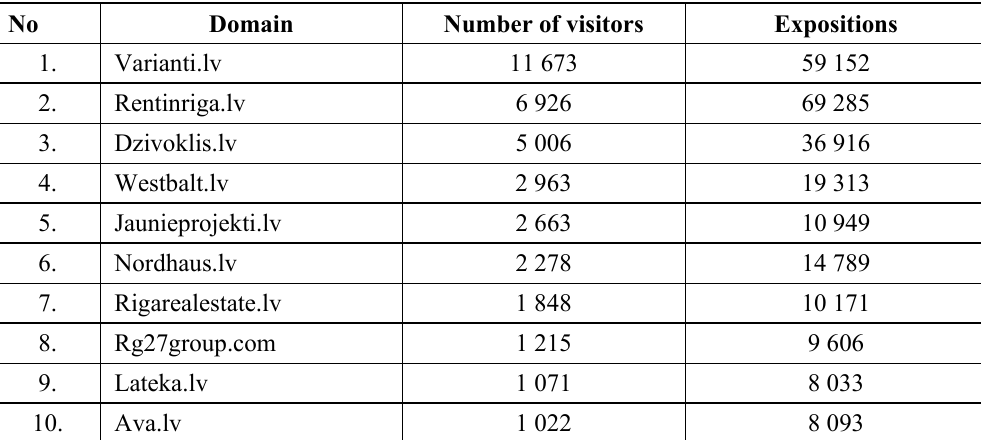
Table 5 . The Real Estate Web Sites Visitors and Explosion Statistics